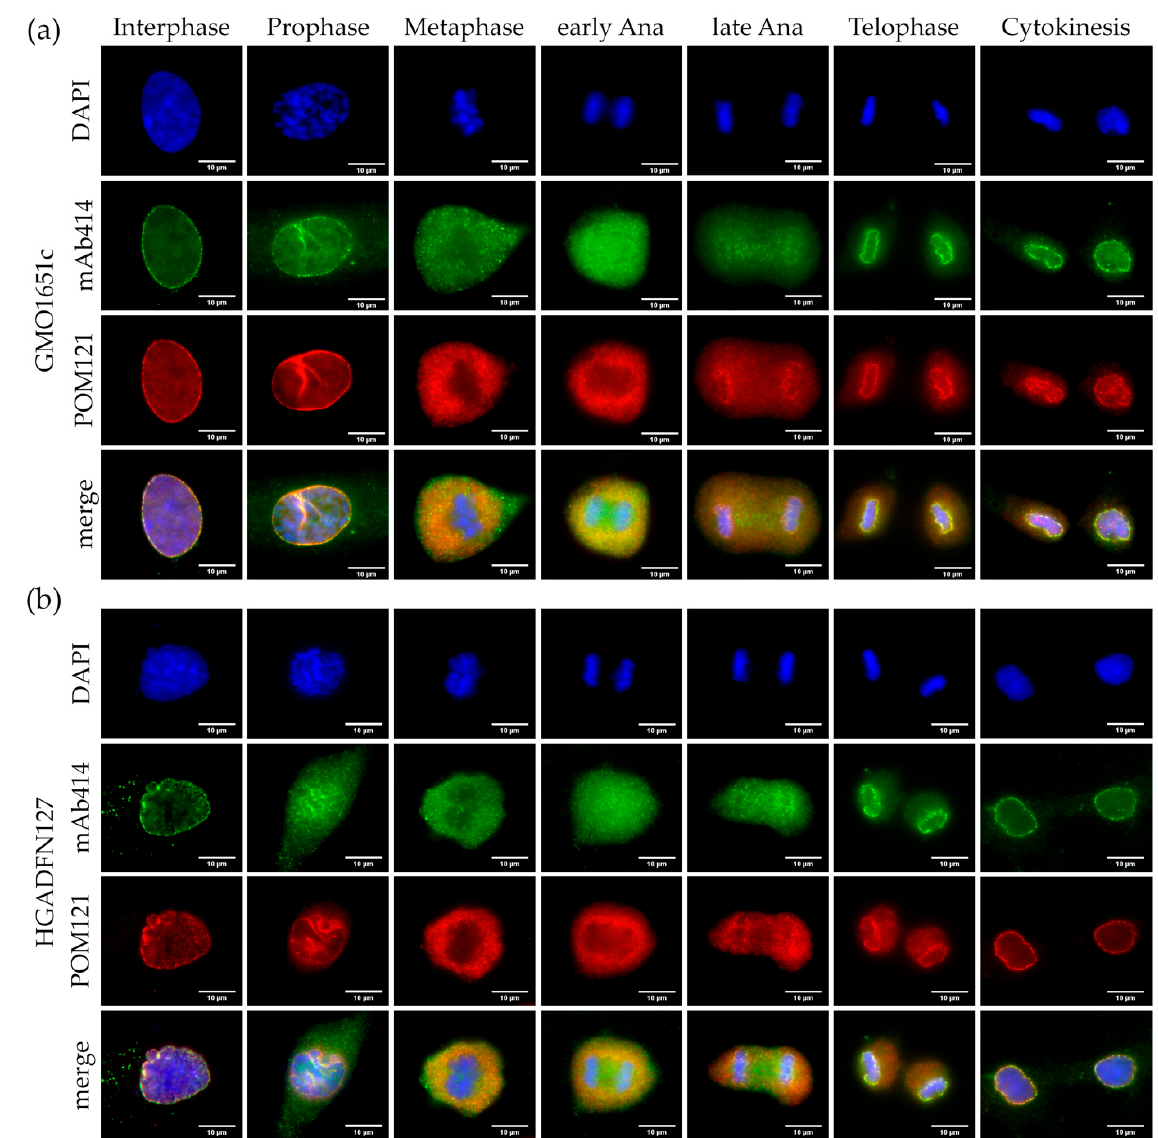
Figure 6. Unlike SUN1, POM121 did not form aggregates in HGPS. Immunocytochemistry of ( a ) control (GMO1651c) and ( b ) HGPS (HGADFN127) fibroblasts using mAb414 and α -POM121 antibody, counterstained with DAPI. POM121 and mAb414 cluster in invaginations of interphase HGPS cells. Neither the localization nor recruitment of mAb414 and POM121 were affected in mitotic HGPS cells when compared to control. n ≥ 3.